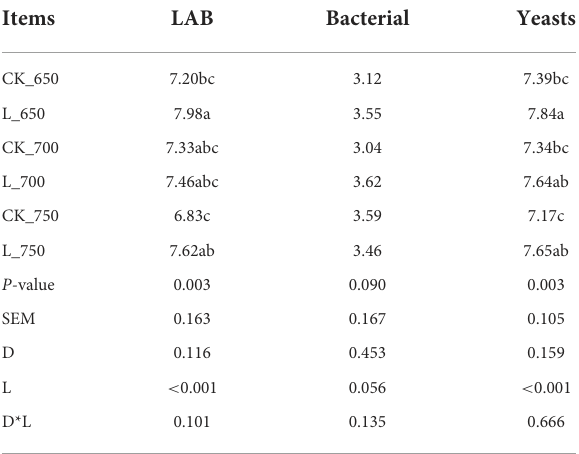
TABLE 4 Microbial counts (log colony-forming units/g fresh weight) in sweet sorghum silages ( n =